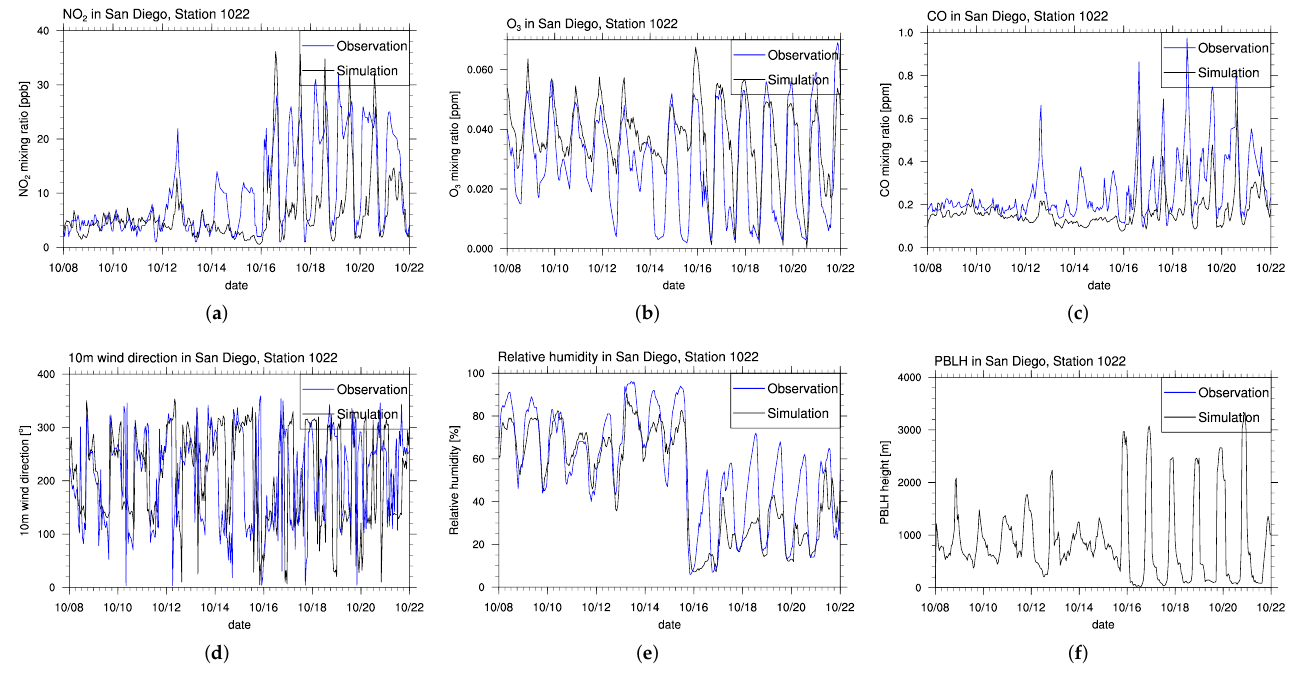
Figure 11. Comparison of in situ measurements with modeled variables at the ground at San Diego, El Cajon, Lexington Elementary School in October 2018. No measurements for the planetary boundary layer height are available.